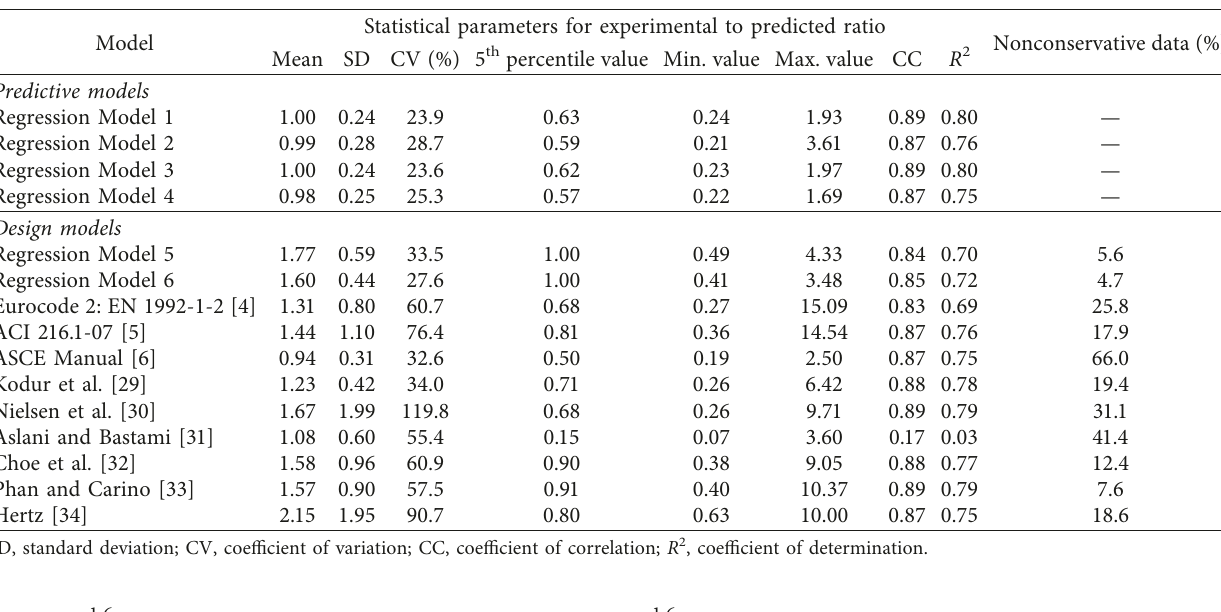
Table 7: Statistical parameters for the assessment of models (485 data points).